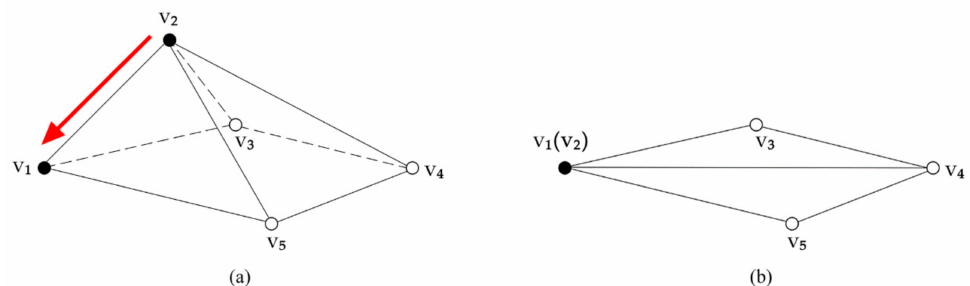
Figure 9. Process of edge collapse in a 3D scene. ( a , b ) represent the state of the mesh in 3D, before and after edge collapse, respectively. The quadric error of v 1 , corresponding to v 2 , is the sum of the square of the distances from v 1 to T[v 1 , v 2 , v 5 ], T[v 1 , v 3 , v 2 ], T[v 2 , v 4 , v 5 ], and T[v 2 , v 3 , v 4 ]. Moreover, the quadric error can represent the variation when the slope of the triangles in the region is going to be changed from large into